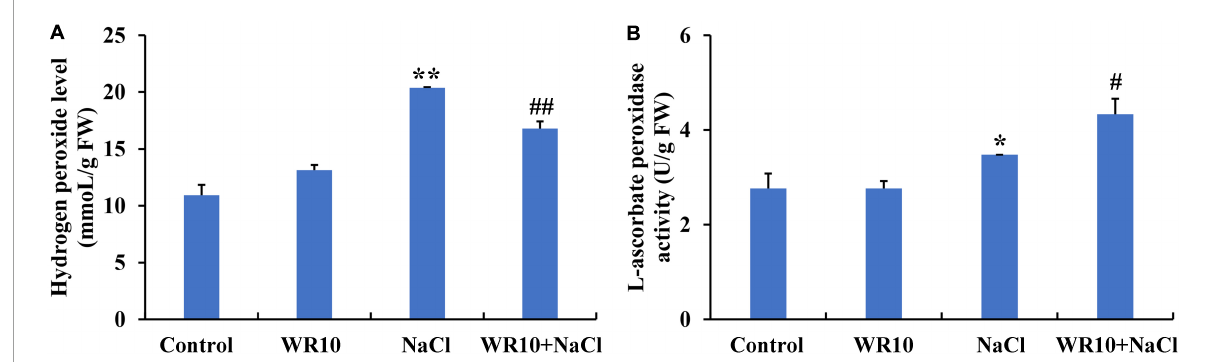
FIGURE4 Bacillus altitudinis WR10 decreases H 2 O 2 levels and increases APX activity in the roots of wheat seedlings under salt stress. (A) H 2 O 2 levels in the roots of wheat seedlings; (B) APX activity in the roots of wheat seedlings. Control, without NaCl and WR10; WR10, with WR10 and without NaCl; NaCl, with NaCl and without WR10; WR10 + NaCl, with NaCl and WR10. Data are expressed as the means ± SD ( n = 6). * p < 0.05, ** p < 0.01 (vs. control); # p < 0.05, ## p < 0.01 (vs. NaCl).